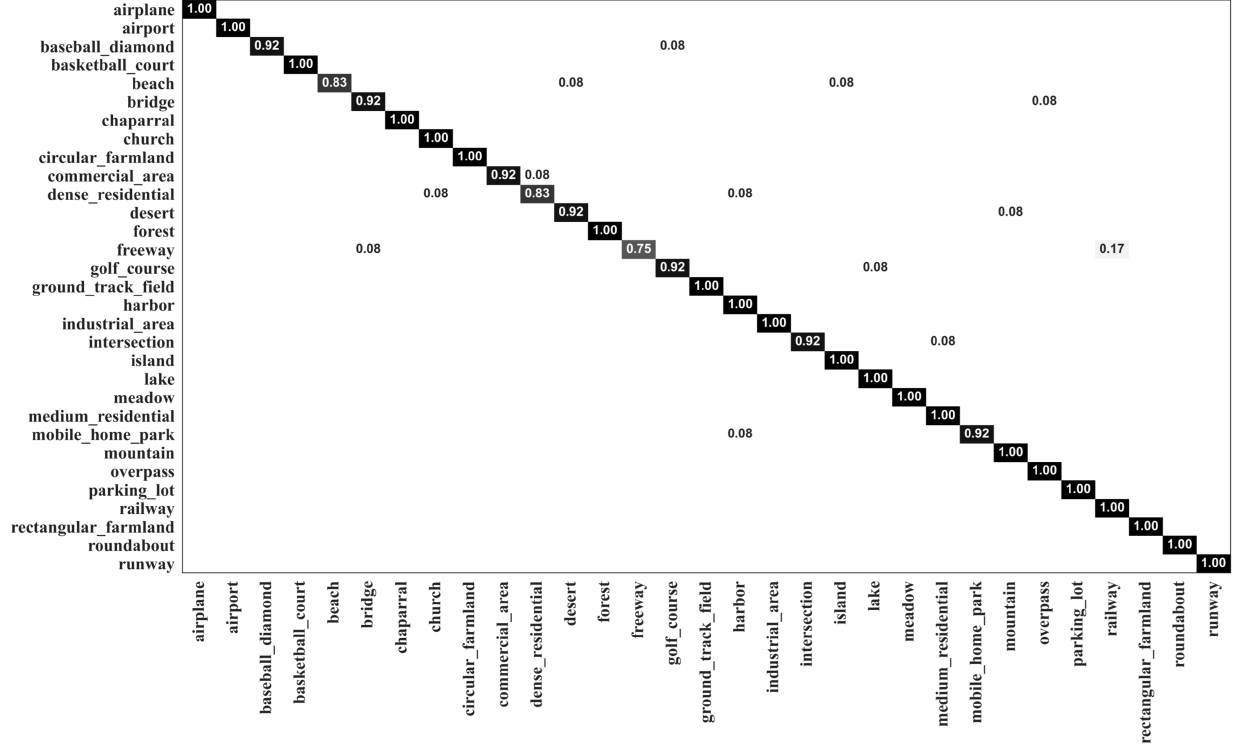
Figure 6. Confusion matrix of MopNet-GAT-ResNet50 on the OPTIMAL-31